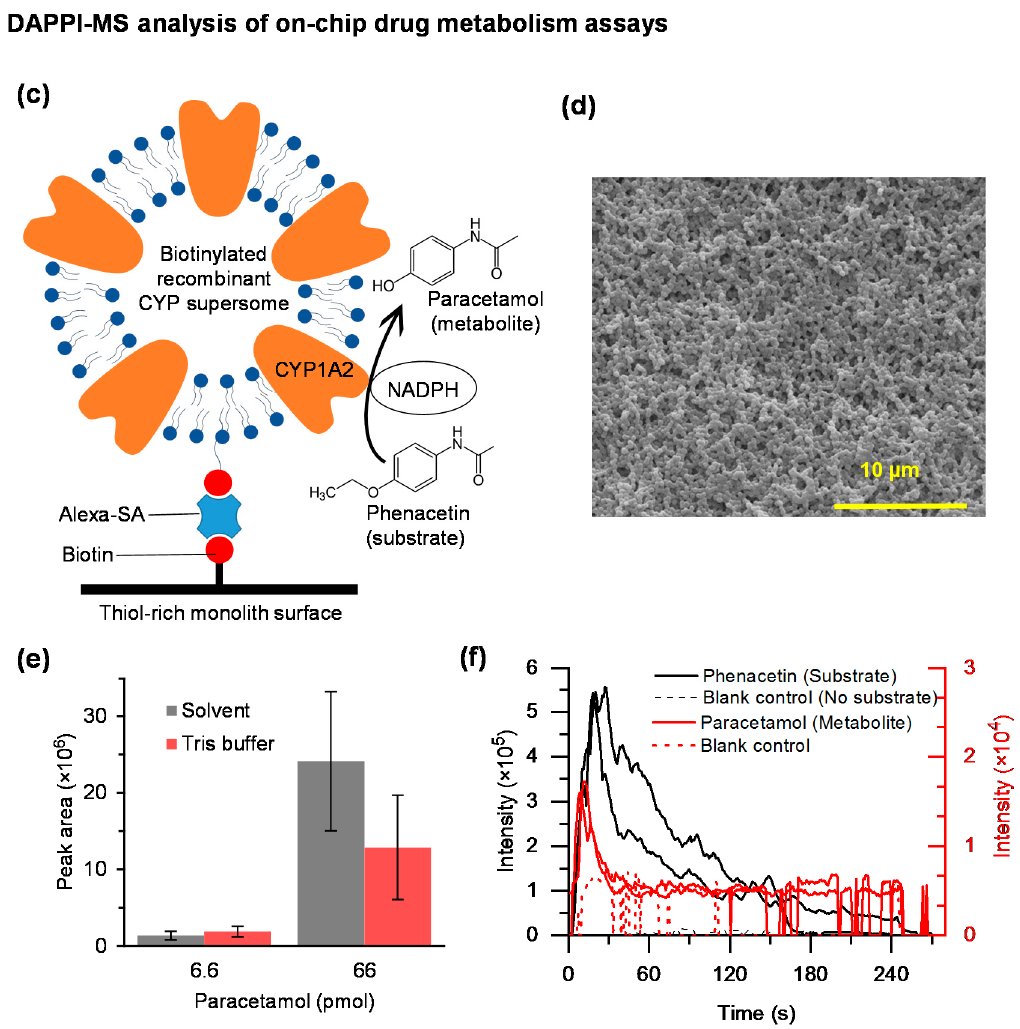
Figure 4. ( a ) Comparison of the repeatability (n = 3 LLE experiments) of intensities of extracted paracetamol (initial amount 300 pmol) and naproxen (initial amount 200 pmol) after LLE and evaporation of the final aqueous acceptor solution. ( b ) Mass spectra of the final acceptor solution featuring abundant paracetamol and naproxen ions. ( c ) Illustration of monolith functionalization and phenacetin-O-deethylation reaction and ( d ) scanning electron microscope image of porous thiol-ene monolith. ( e ) Comparison of paracetamol signal intensities in pure solvent (methanol-water 1:1) vs. 60 mM Tris buffer (n = 5 samples each). ( f ) EICs of paracetamol (red line) produced via CYP1A2 mediated phenacetin (black line) O-dealkylation analyzed from the dried precipitate of the enzymatic reaction solution after the on-chip drug metabolism assays.